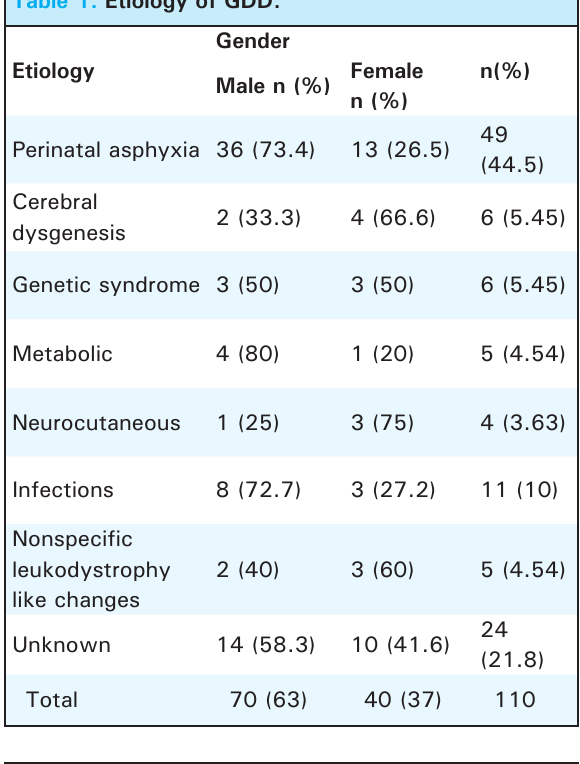
Table 1. Etiology of GDD.